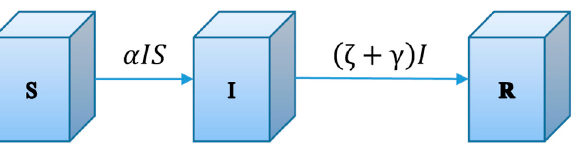
Figure 2. The compartmental diagram for the SIR model. Flows represent the fractions of the total populations flows from the donor compartments per unit time.